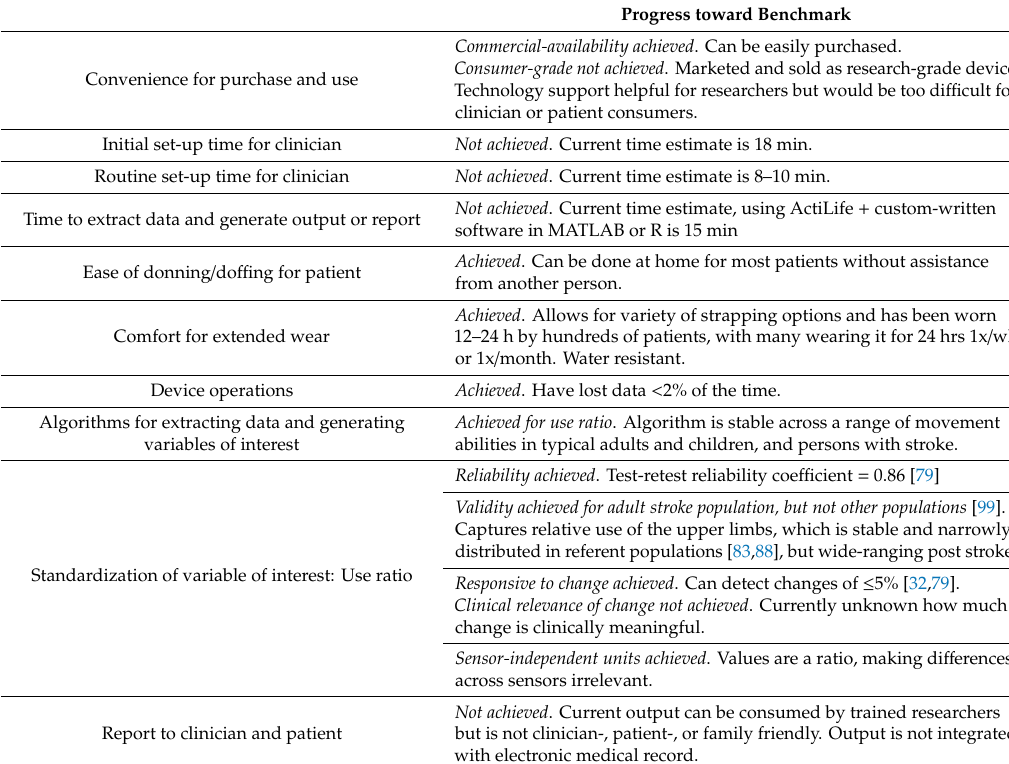
Table 3. Application of benchmarks to a current wearable device system, the Actigraph wGT3X-BT and ActiLife software for measuring upper limb performance in daily life, indexed by the use ratio